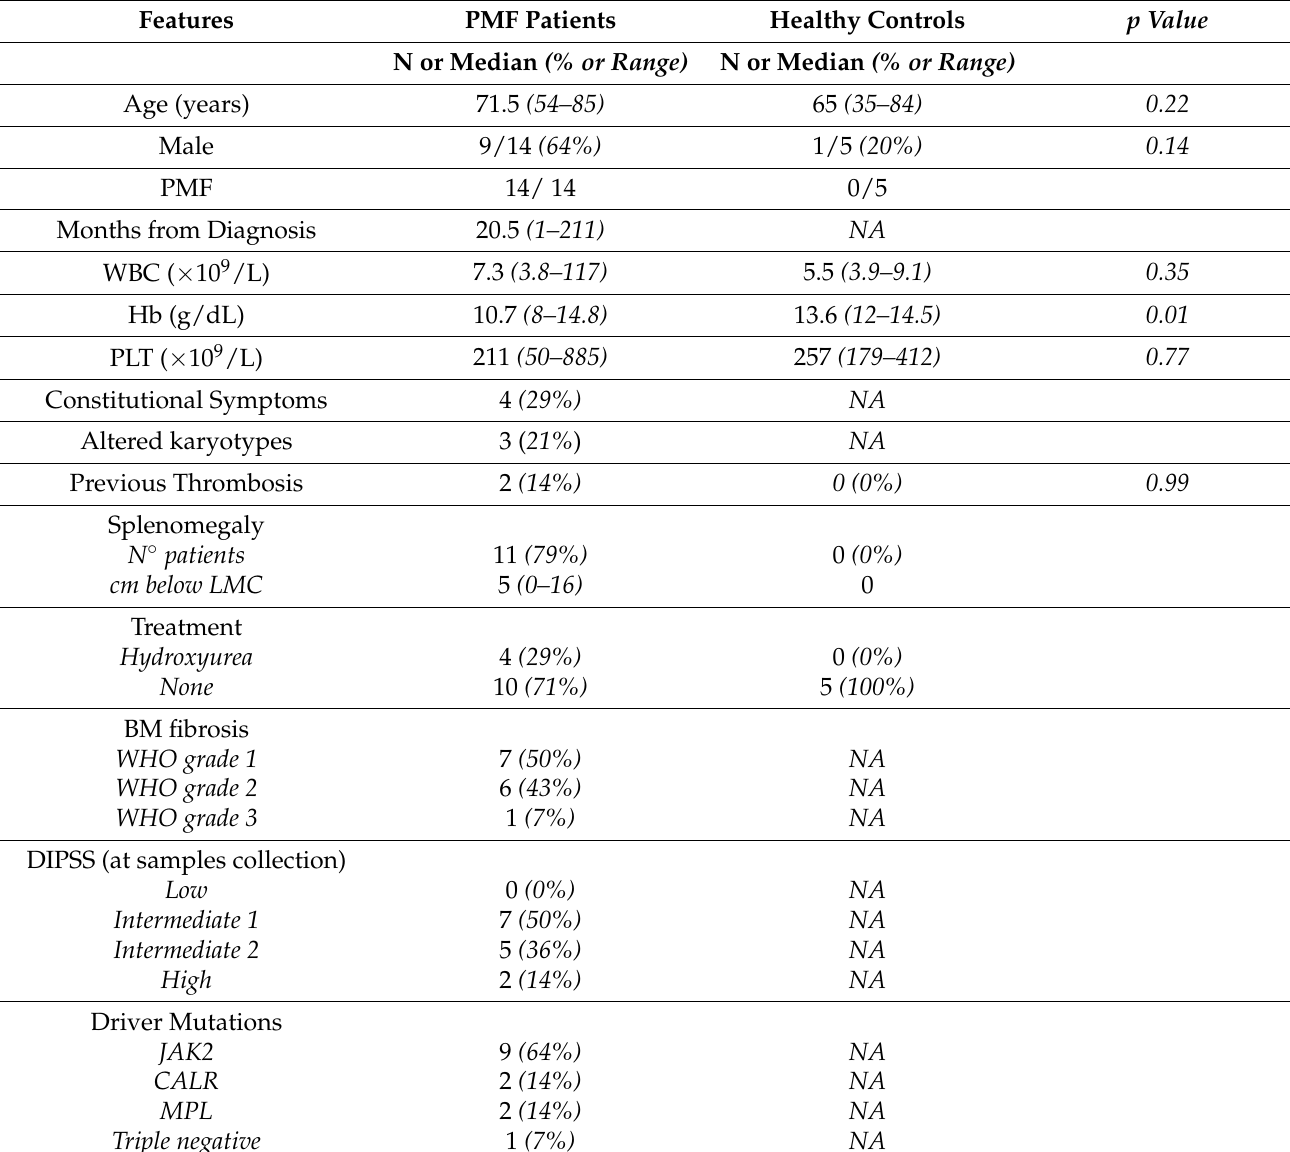
Table 1. Patients and healthy controls